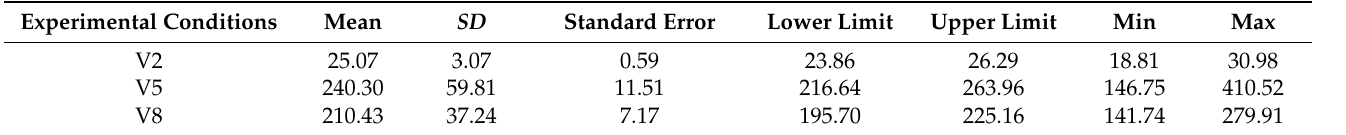
Table 5. Time spent in the pairing cards